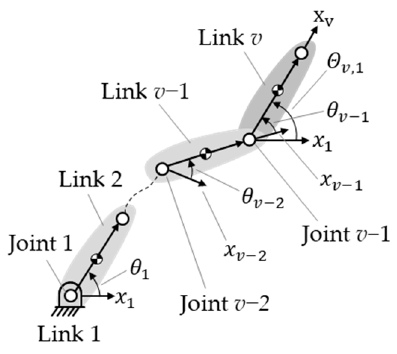
Figure 2. Accumulated joint angles from joints between link v and link 1.